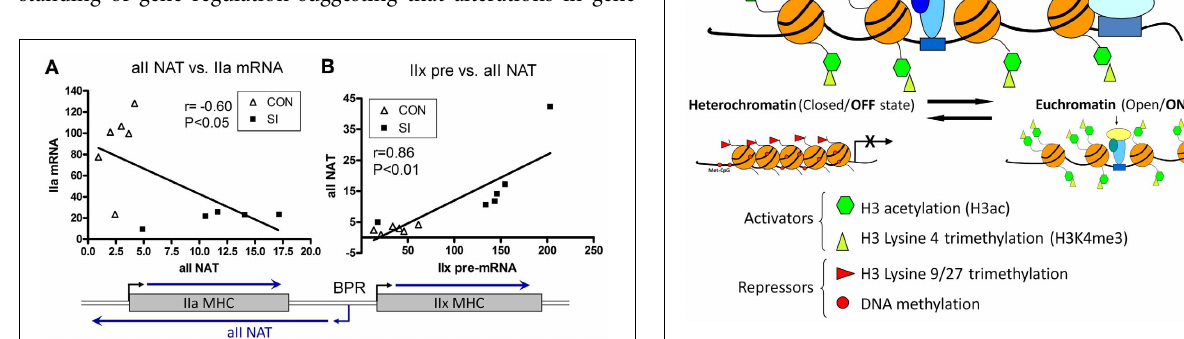
FIGURE 8 | Relationship between Sense and Antisense Transcripts in Soleus Muscle. IIa mRNA is inversely proportional to IIa NAT (A) ; whereas IIx pre-mRNA is correlated positively to IIa NAT (B) . Lines are generated by regression analyses (GraphPad Prism). r, Pearson coefficient determined with correlation analyses for each set. Open triangle, control; closed square, SI. Also shown is a schematic of the IIa and IIx genes, and transcriptional activity in the intergenic region depicting a bidirectional promoter (BPR) in the IIx 5 (cid:6) proximal region (Pandorf et al., 2006).